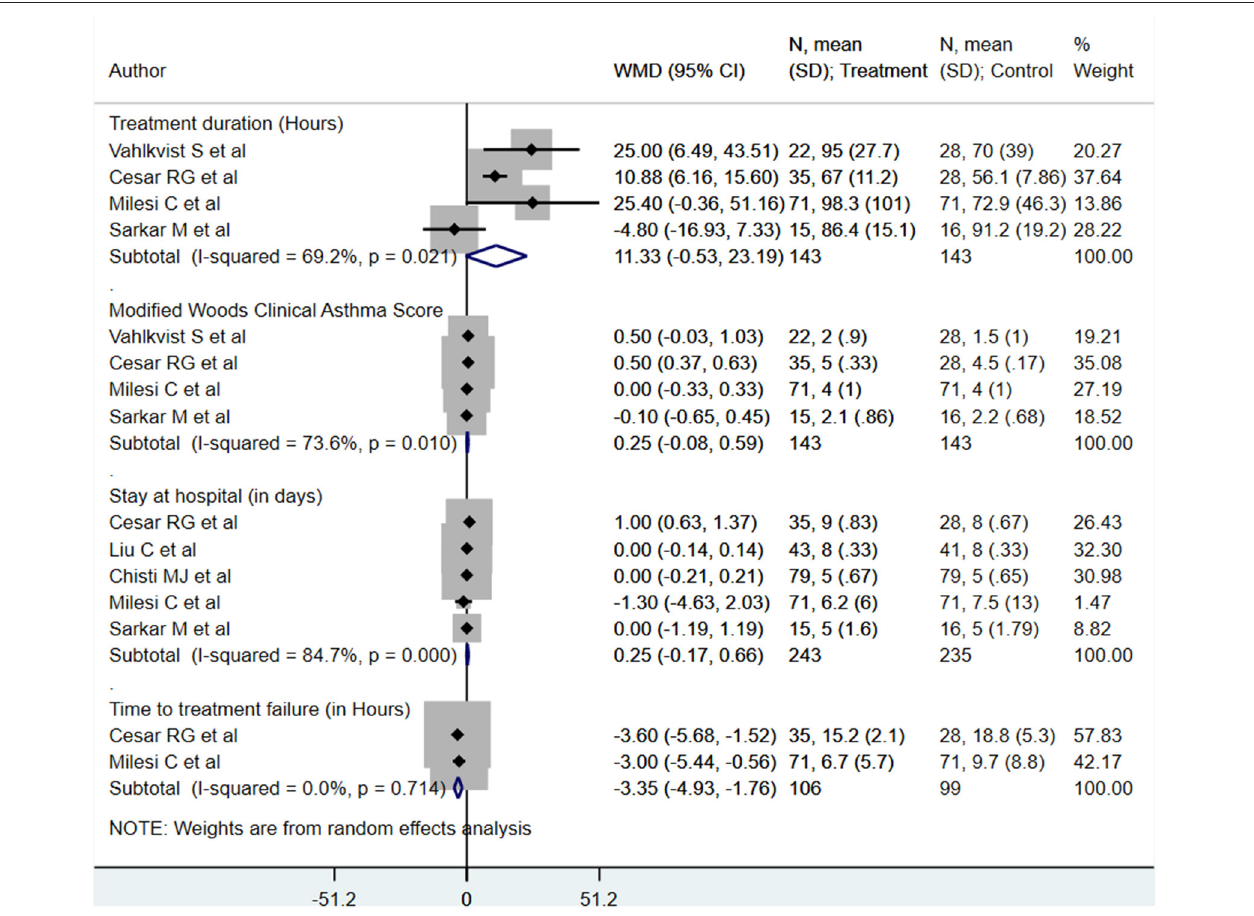
FIGURE 3 | Effects of HFNC vs. CPAP on primary treatment duration, modified Woods clinical asthma score, hospitalization length, and time to treatment